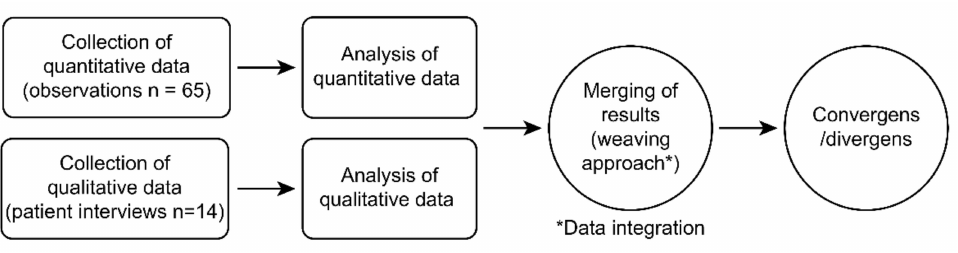
Figure 1. Overview of convergent parallel